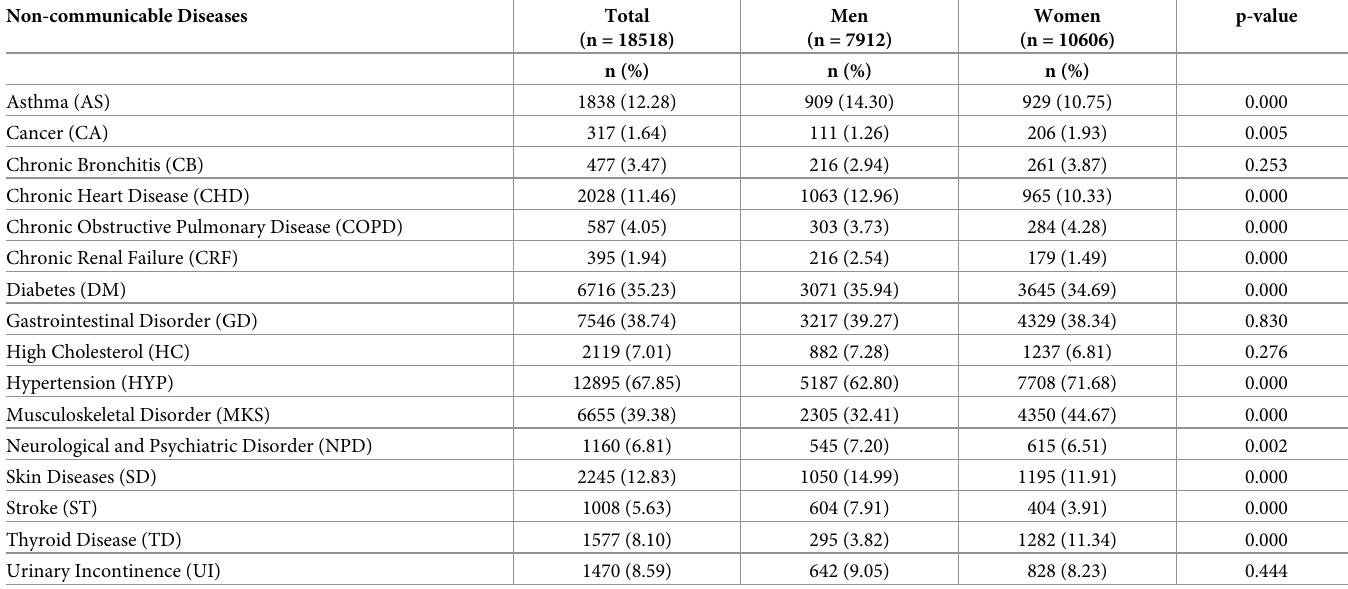
Table 1. Prevalence of selected chronic morbidities in the population stratified by gender, longitudinal study in India, 2017–18. Non-communicable Diseases